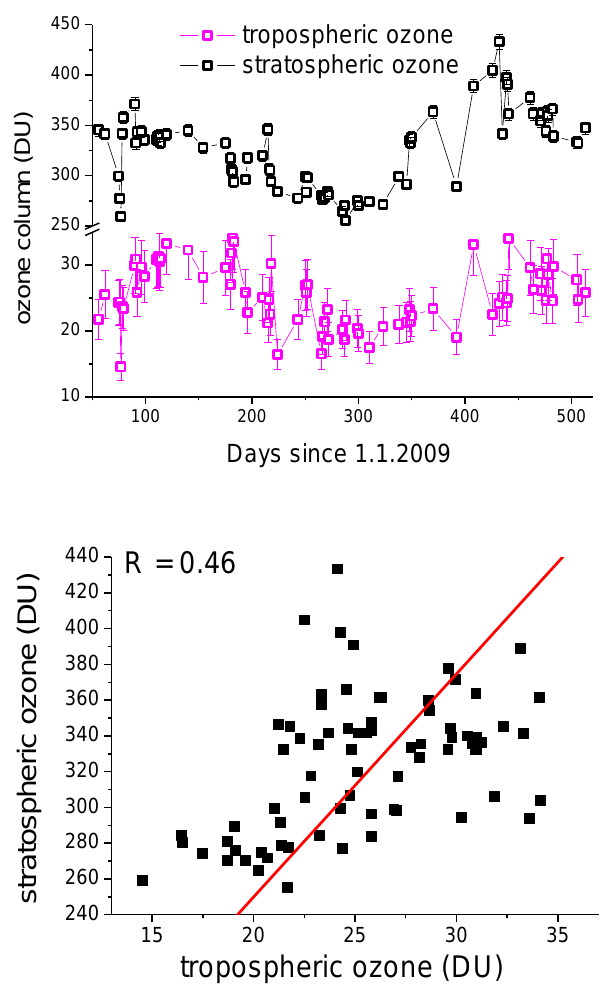
Fig. 3. Upper plot: times series of tropospheric (pink symbols) and stratospheric (black symbols) ozone columns derived from OASIS measurements from 25 February 2009 to 28 May 2010 at Cr´eteil (France). Lower plot: stratospheric ozone related to tropospheric ozone derived from OASIS spectra. The red line is a linear fit with zero intercept.